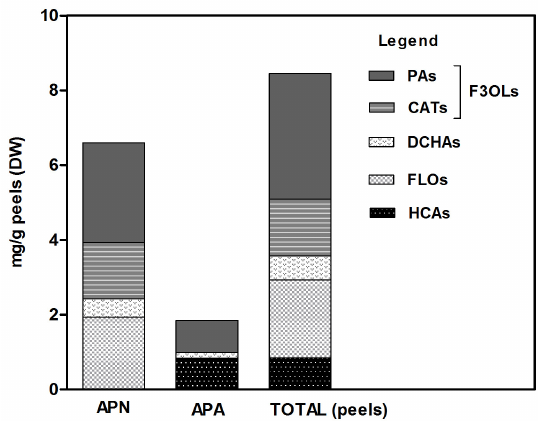
Figure 1. Phenolic composition of neutral (APN) and acidic (APA) phenolic extracts from apple peels. CATs, catechins; PAs, proanthocyanidins (oligomers, up to four units); F3OLs, flavan-3-ols; DCHAs, dihydrochalcone derivatives; FLOs, flavonol glycosides; HCAs, hydroxycinnamic acids and derivatives.